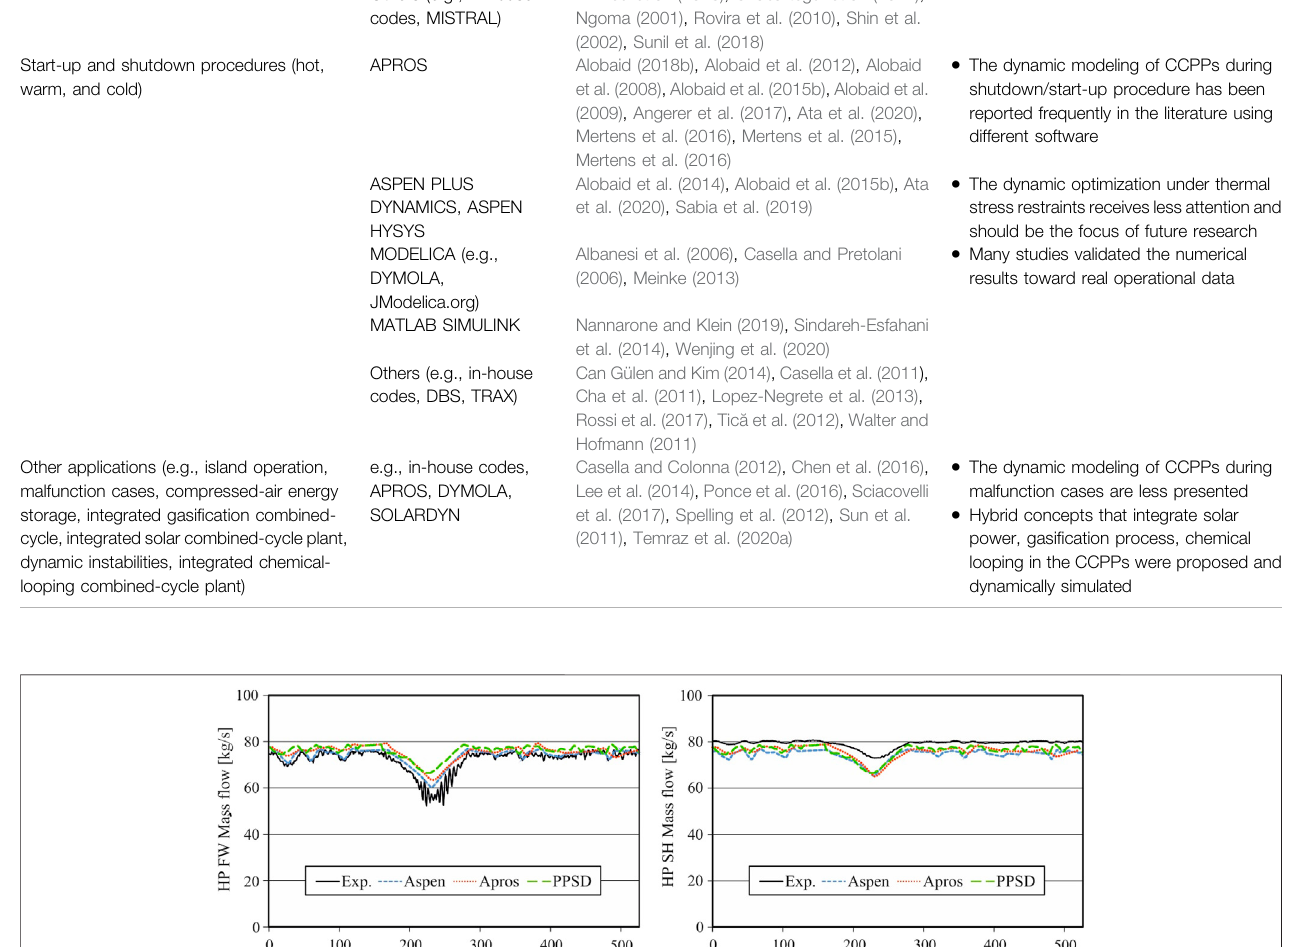
Frontiers in Energy Research |